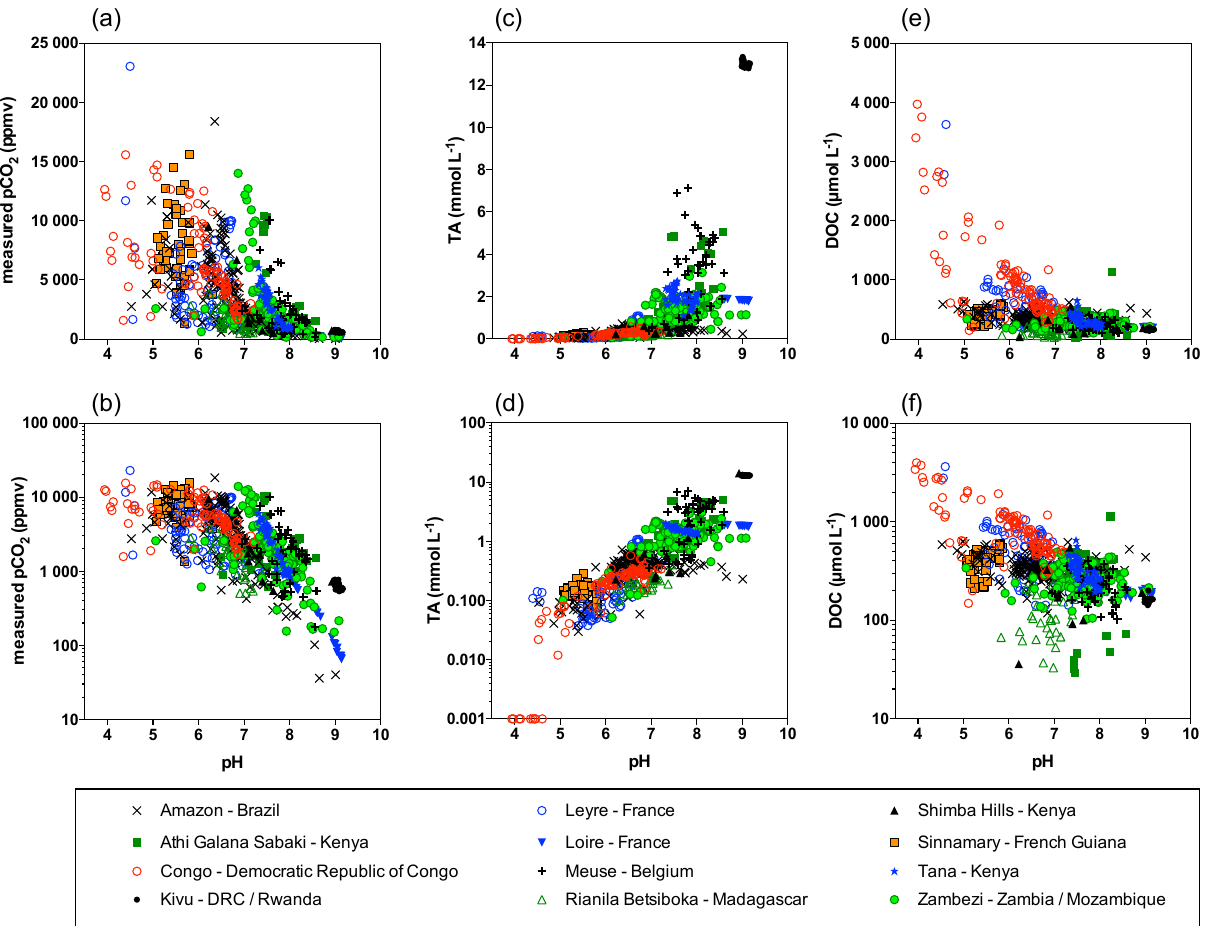
Figure 3. Plot of carbon variables vs. pH in the studied freshwater systems. Top panels are shown with a linear scale and bottom panels with a logarithmic scale; (a, b) : measured p CO 2 ; (c, d) total alkalinity; (e, f) DOC. Zero TA values are plotted as 0.001 in order to be visible on the log p CO 2 scale. Rianila and Betsiboka are plotted together although they belong to different watersheds in